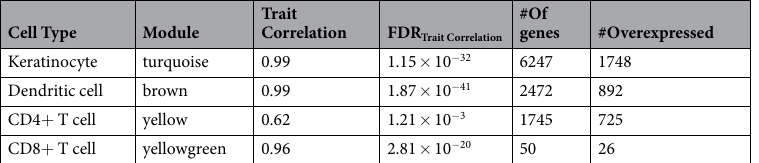
Cell Type Module